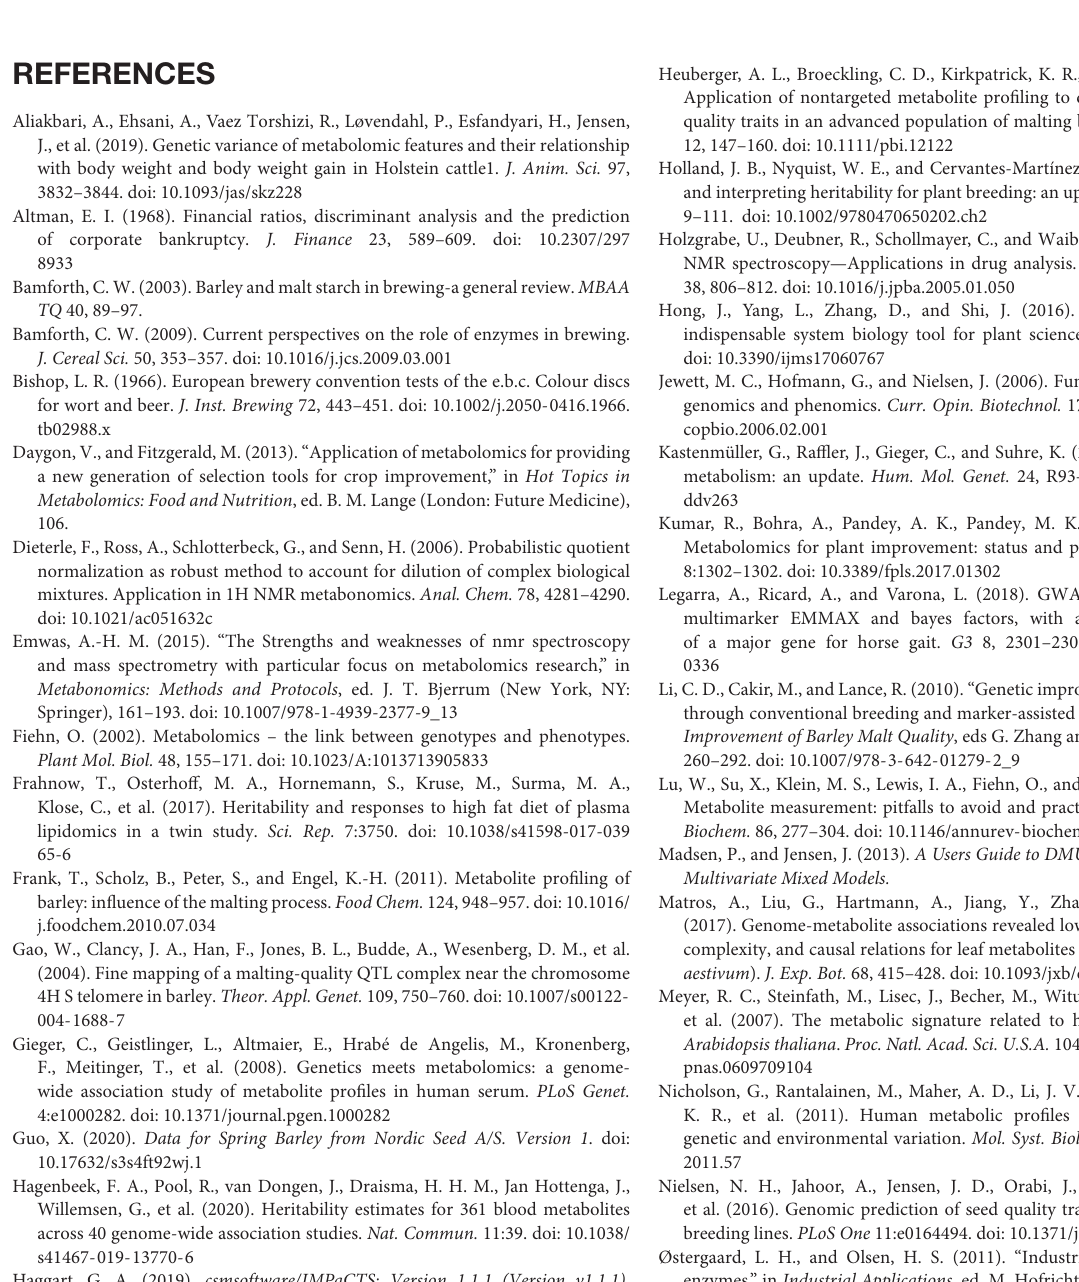
Supplementary Table S4 | Descriptive statistics for genetic correlations between 8,604 significantly heritable metabolomic features and malting quality traits.